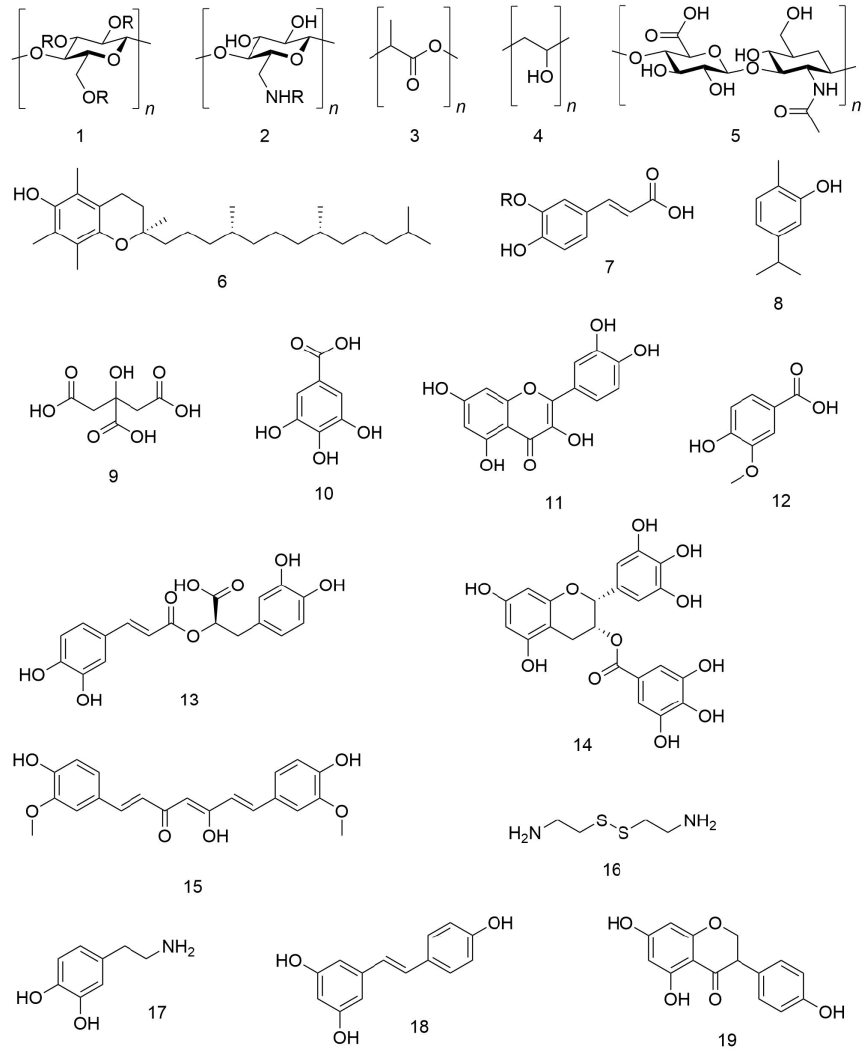
Figure 1. Chemical structures of the main compounds exploited to reduce the oxidative stress, either alone, grafted onto a polymer, or encapsulated into NPs. ( 1 ) R = H, cellulose; R = CH 2 COOH, carboxymethyl cellulose; ( 2 ) R = either H or COCH 3 depending on the degree of deacetylation, chitosan; ( 3 ) polylactic acid; ( 4 ) polyvinyl alcohol; ( 5 ) hyaluronic acid; ( 6 ) α − tocopherol; ( 7 ) R = H, caffeic acid; R = CH 3 , ferulic acid; 8 ) carvacrol; 9 ) citric acid; 10 ) gallic acid; 11 ) quercetin; 12 ) vanillic acid; 13 )